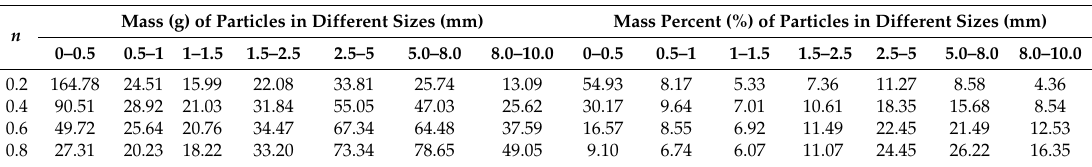
Table 3. Distribution of particles under different Talbot indices.